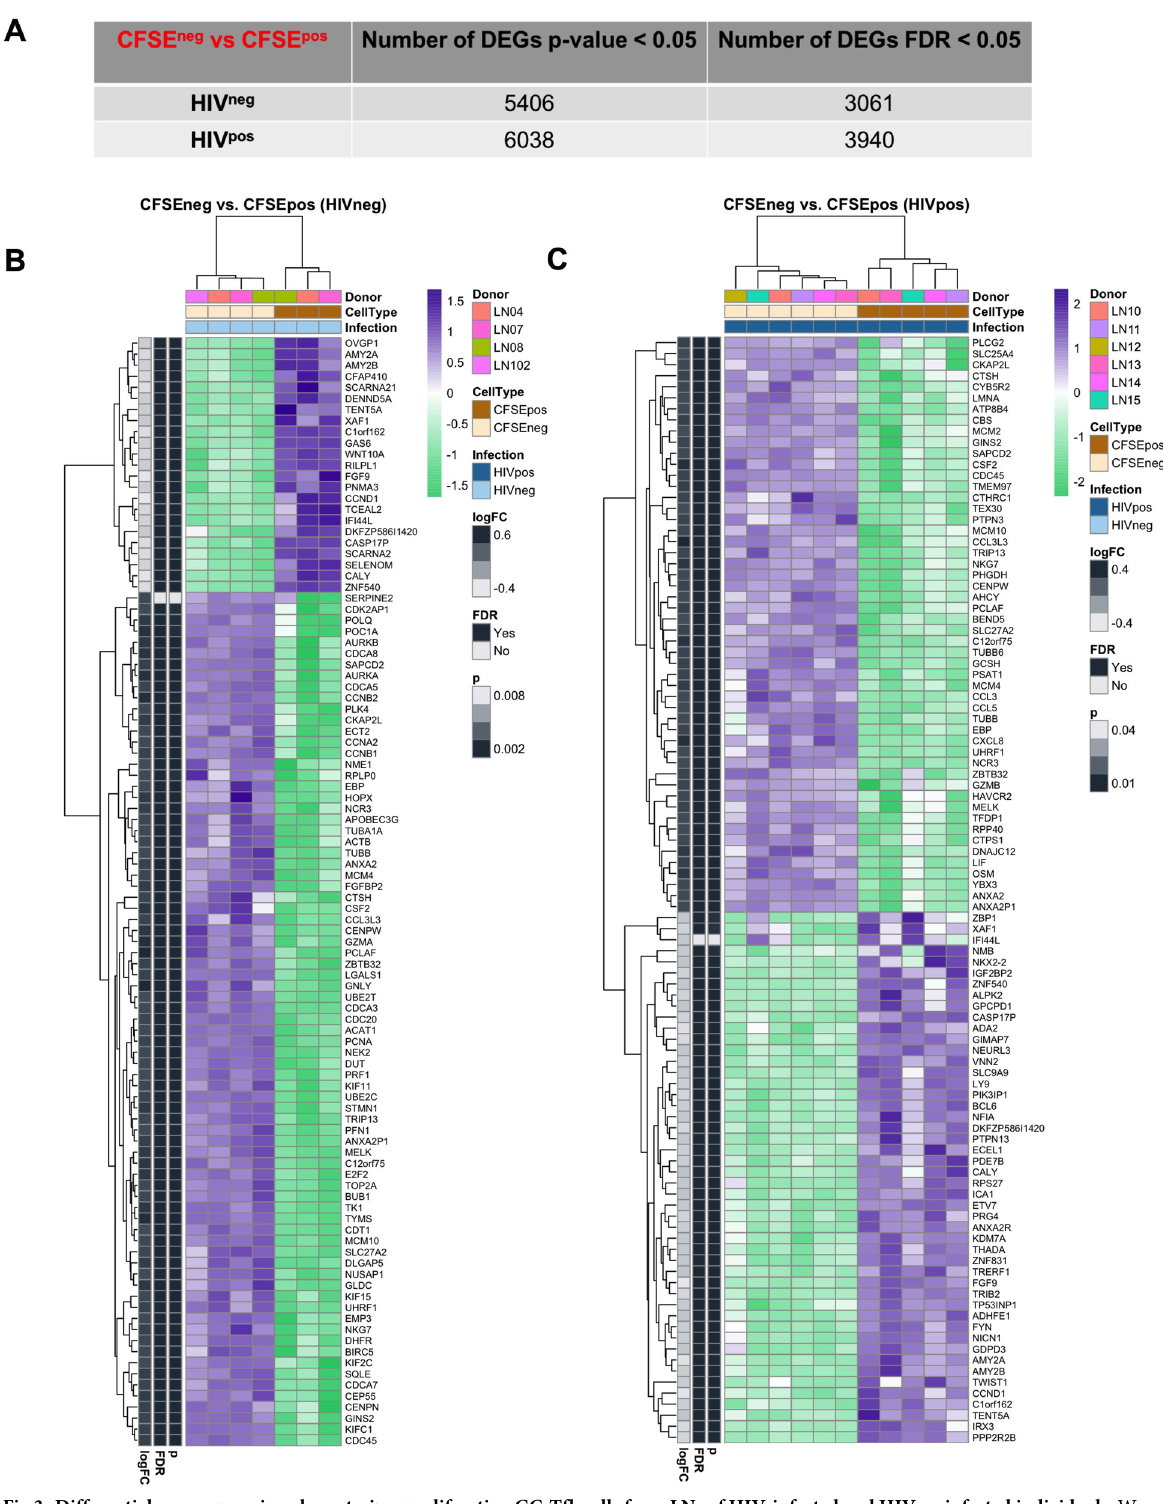
Fig 3. Differential gene expression characterizes proliferating GC-Tfh cells from LNs of HIV-infected and HIV-uninfected individuals. We used single-gene analysis to determine the pattern of gene expression in proliferating LN GC-Tfh cells in co-culture with autologous GC-B cells